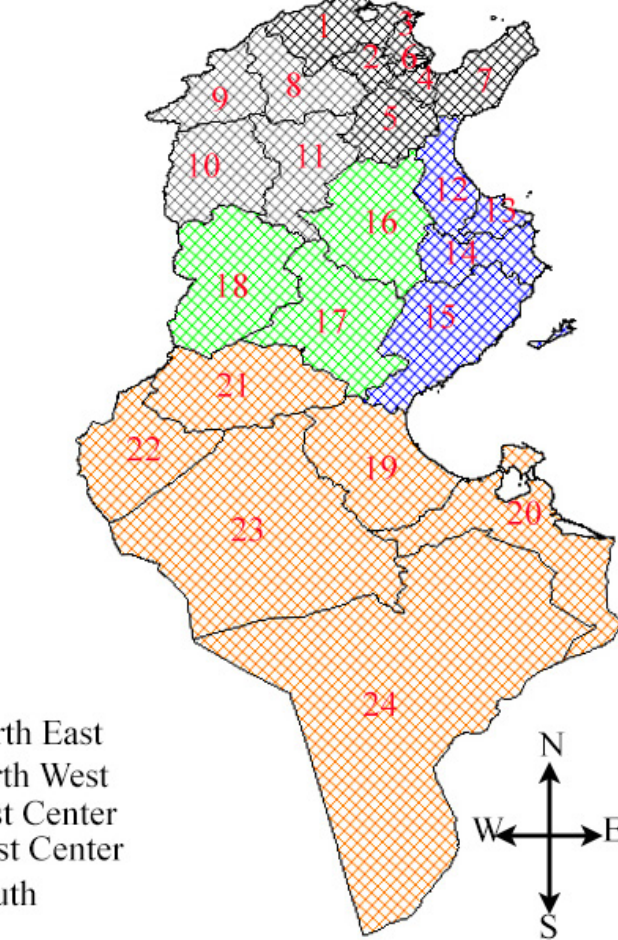
Fig 1. Provinces of Tunisia: 1. Bizerte; 2. Mannouba; 3. Ariana 4. Ben Arous; 5. Zaghouan; 6. Tunis; 7. Nabeul; 8. Beja; 9. Jendouba; 10. Le Kef; 11. Siliana; 12. Sousse; 13. Monastir; 14. Mahdia; 15. Sfax; 16. Kairouan; 17. Sidi Bouzid; 18. Kasserine; 19. Gabes; 20. Medenine; 21. Gafsa; 22. Tozeur; 23. Kebili; 24.